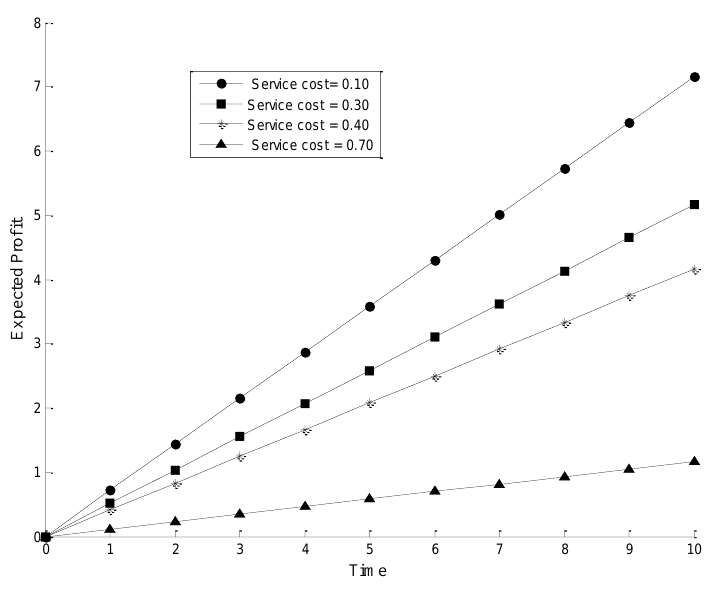
Figure 5. Expected profit as a function of time in Comprehensive